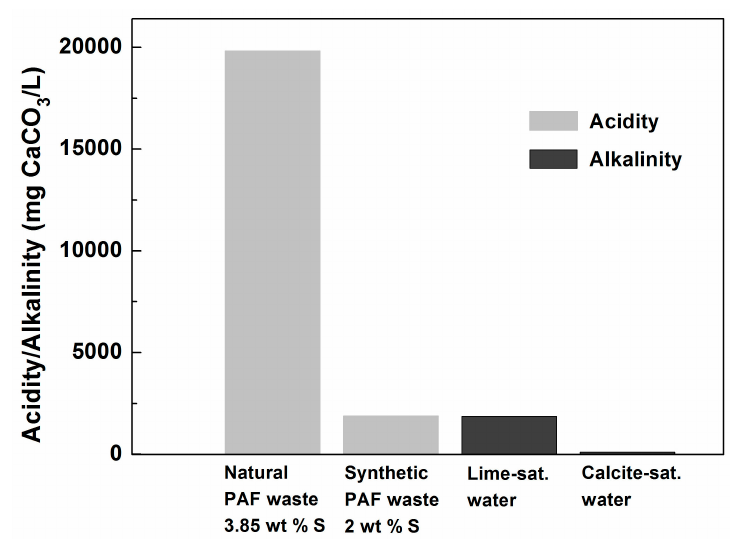
Figure 6. Peak leachate acidities from KLC tests for the natural and synthetic PAF wastes, alongside alkalinities available from saturated lime and calcite solutions.